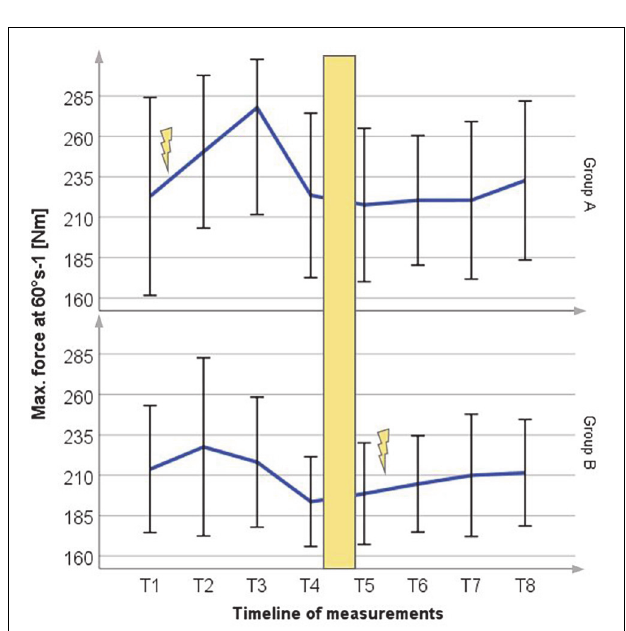
FIGURE 3 | Mean ( ± SD) change in jump height for Group A period 1 and Group B period 2. Lightning bolt represents each respective WB-EMS period; yellow area = wash-out phase.